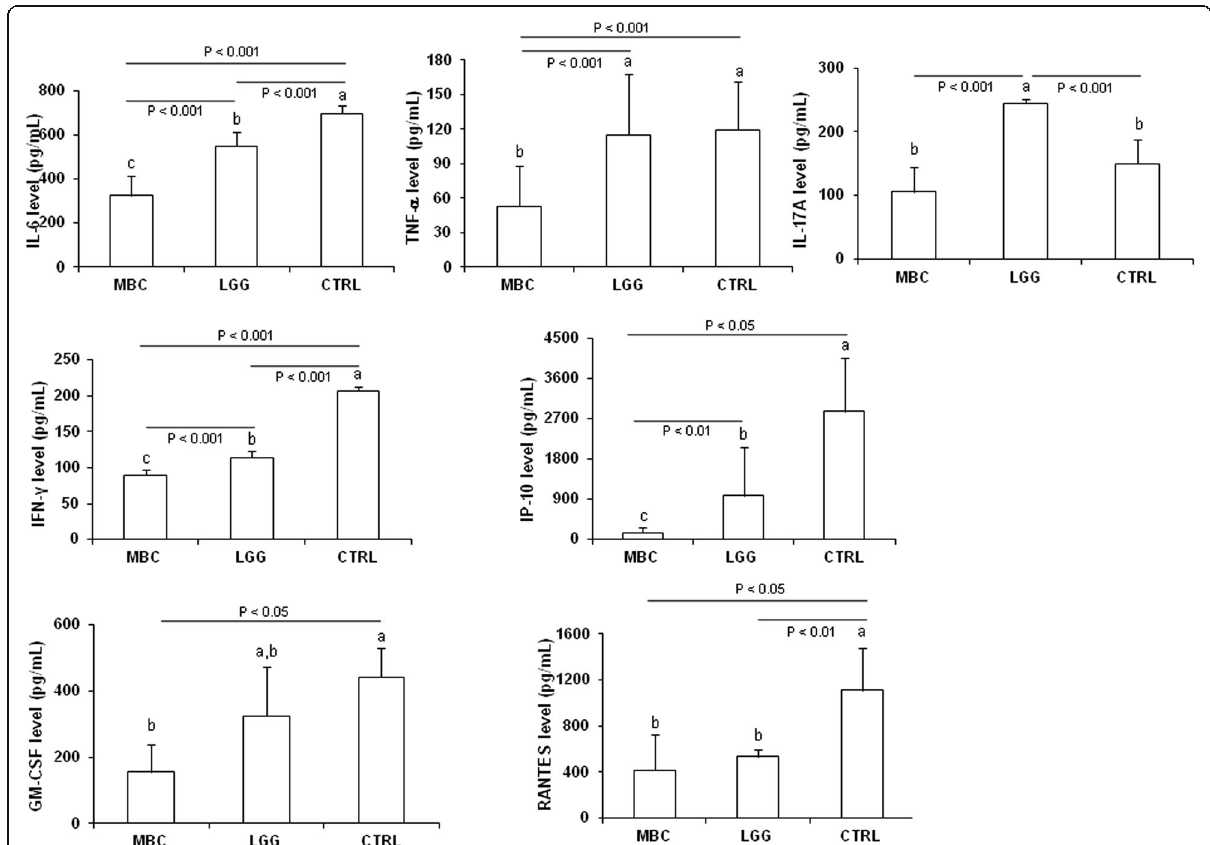
Fig. 3 Cytokine and chemokine secretion in epididymal WAT explants. WAT explants were cultured in complete DMEM for 24 h in the presence of ionomycin (1 ng/ml) and PMA (5 ng/ml). Cytokine and chemokine levels were analysed by Luminex assay or by ELISA (see the “ Methods ” section). Each column represents the mean ± SD of nine mice. Means without a common letter significantly